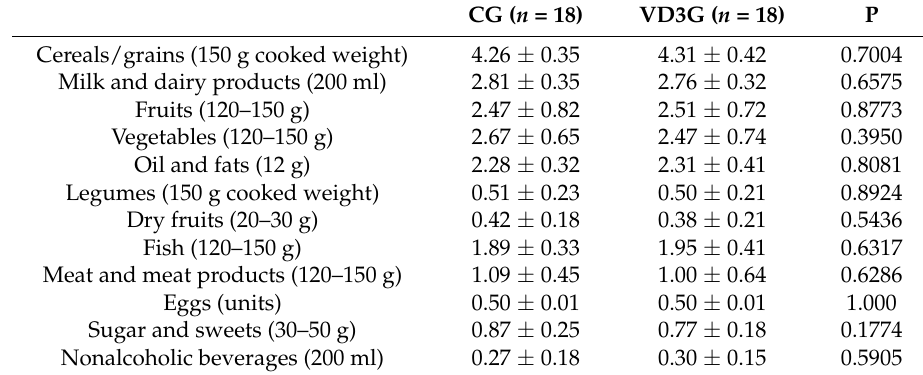
Table 5. Daily number of portions of different food groups in the control group (CG) and vitamin D3 group (VD3G) during 8 weeks of study.